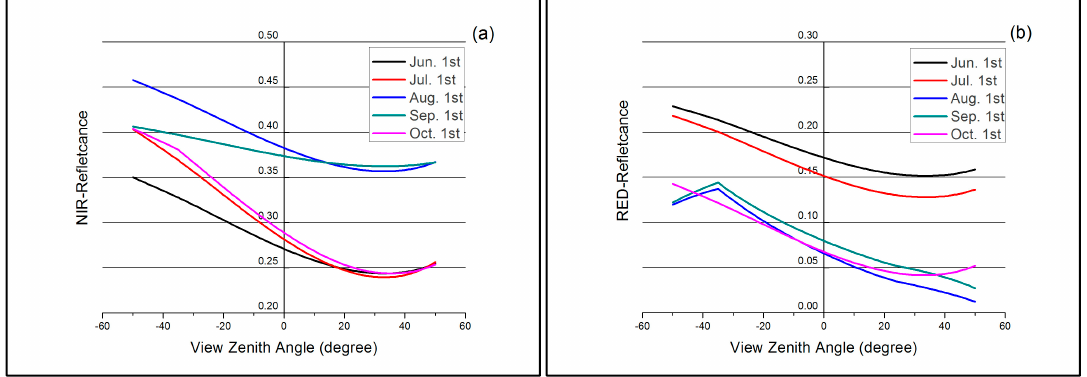
Figure 4. Simulated: ( a ) near-infrared (NIR); and ( b ) RED reflectances at Yingke station according to changes in the view zenith angle on the first day of the month, for five months.